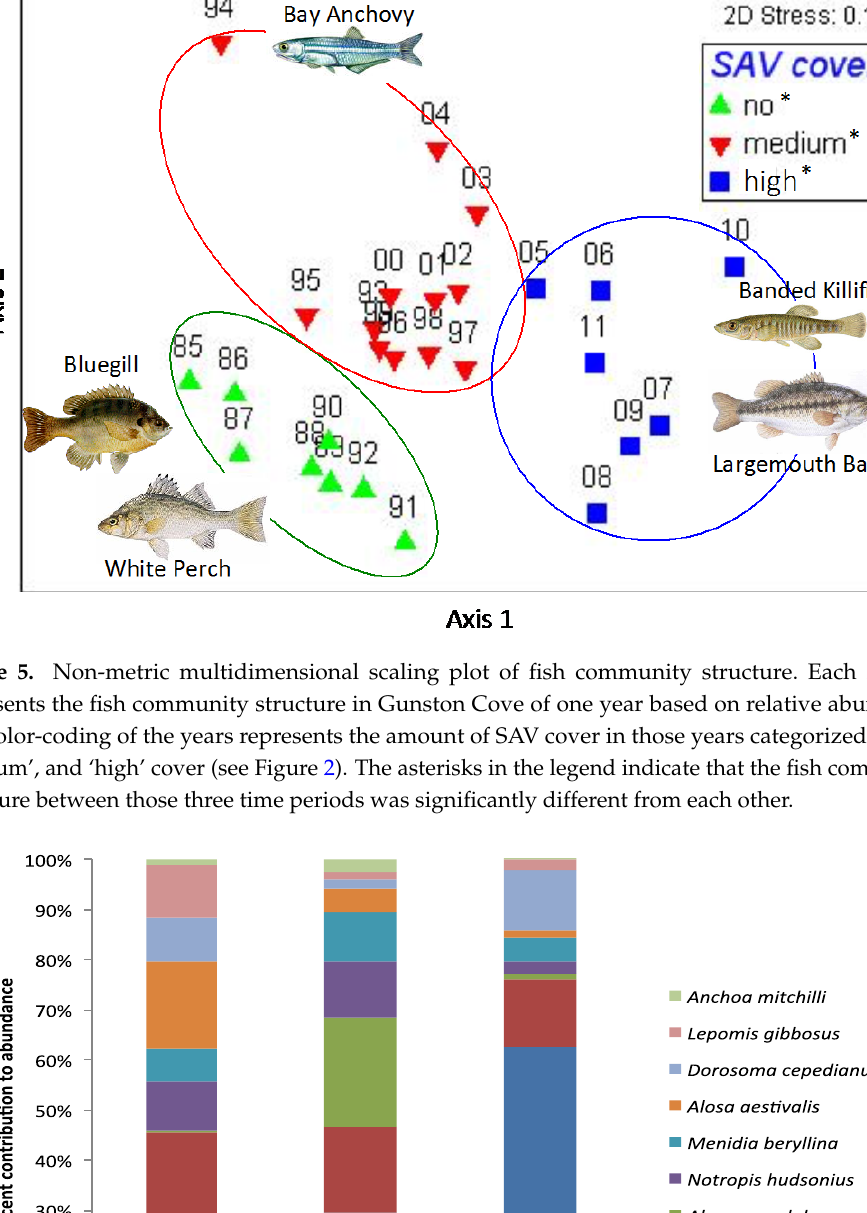
Figure 4. Total fish abundance per seine haul for the three time periods of 1985–1992, 1993–2004, and 2005–2011. Error bars indicate standard error. The labels ‘no’, ‘medium’, and ‘high’ refer to the SAV cover.